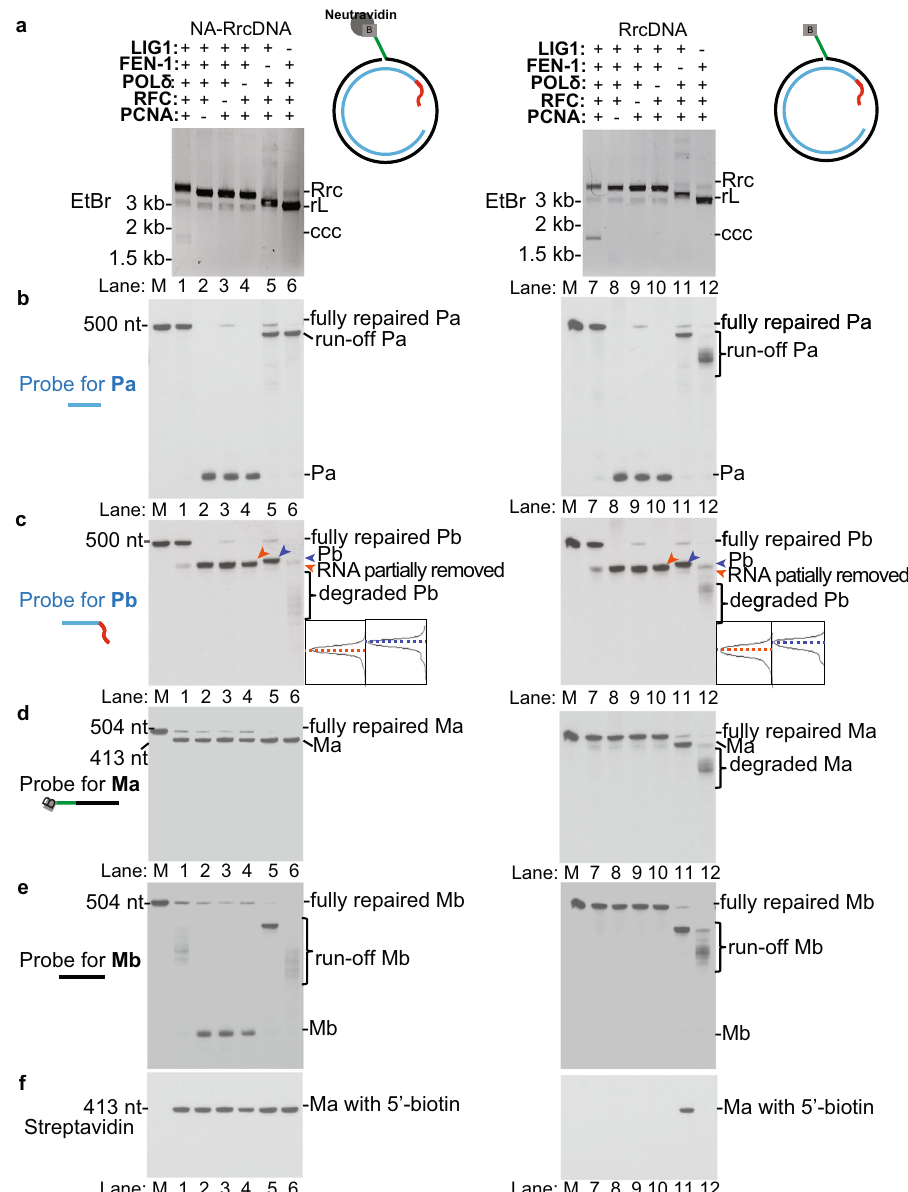
Fig. 4 Determination of repair intermediates generated when individual human repair factors are omitted. a cccDNA formation of NA-RrcDNA (lanes 1 – 6) or RrcDNA (lanes 7 – 12) by puri fi ed human factors was detected by agarose gel electrophoresis containing EtBr. Omission of the factors is indicated by “ − ” . b Repair products from a were digested with Aat II/ Psi I and the repair of the plus-strand Pa fragment was monitored by Southern blot as in Fig. 2d. c Repair of the RNA primer-containing Pb fragment was detected by Southern blot as in Fig. 2e. Traces with dashed blue and orange line denote unrepaired (blue arrow head) and repaired (orange arrow head) products of Pb fragments. d – e Repair of minus-strand Ma and Mb fragments were monitored by Southern blot as in Fig. 2f, g. f Removal of the biotin-containing fl ap of Ma is detected by Streptavidin blot as in Fig. 2h. Rrc, RrcDNA; rL, recombinant linear RrcDNA; ccc, cccDNA. Of note, this fi gure is related to Supplementary Figure 6, and sections “ Omission of individual human factors leads to distinct repair intermediates of the plus-strand ” and “ Omission of individual human factors leads to distinct repair intermediates of the minus-strand ” in the main text. Please refer to these for a comprehensive analysis for the content presented in this fi gure. All experiments were repeated twice independently. Source data are provided as a Source Data fi